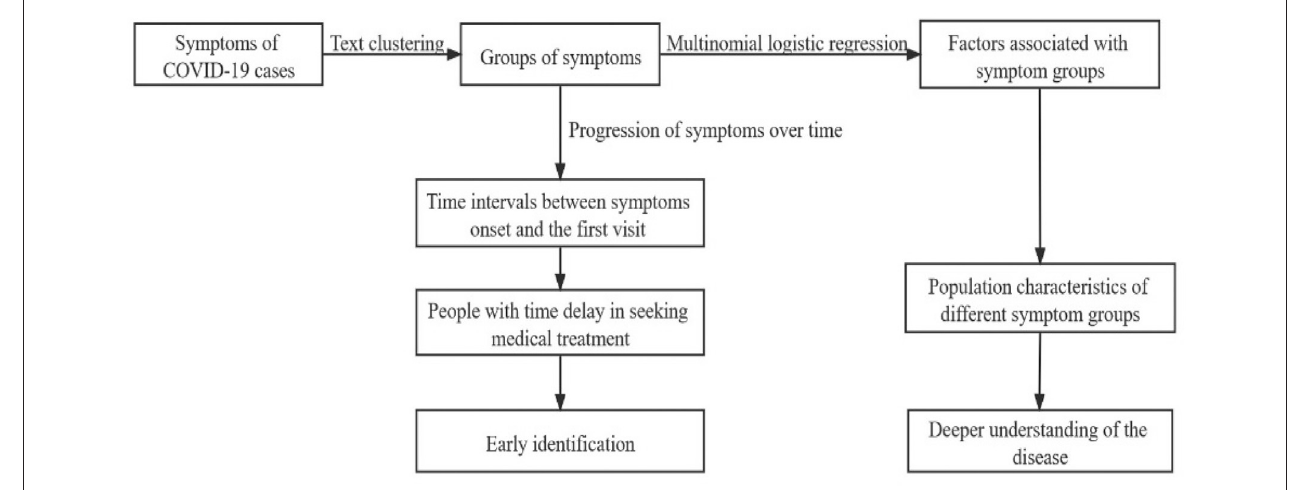
FIGURE 1 | The procedure of analysis in this